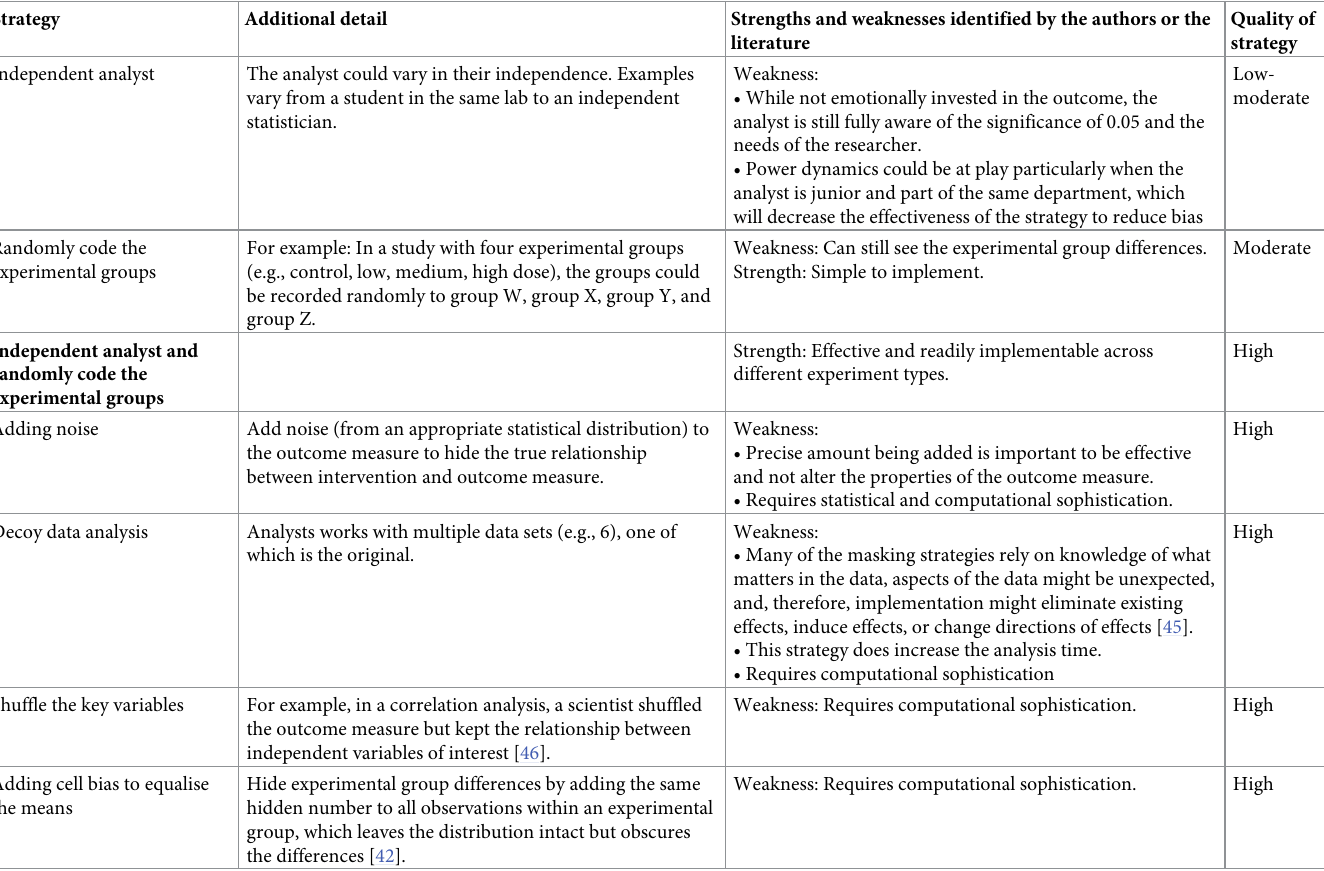
Table 5. Example of strategies to implement masking during data analysis. We have classified the masking options as either low, moderate, or high based on the ability to minimise risk of bias. Shown in bold is the recommended high-quality strategy that is readily implementable across different experiment types. Strategy Additional detail Independent analyst